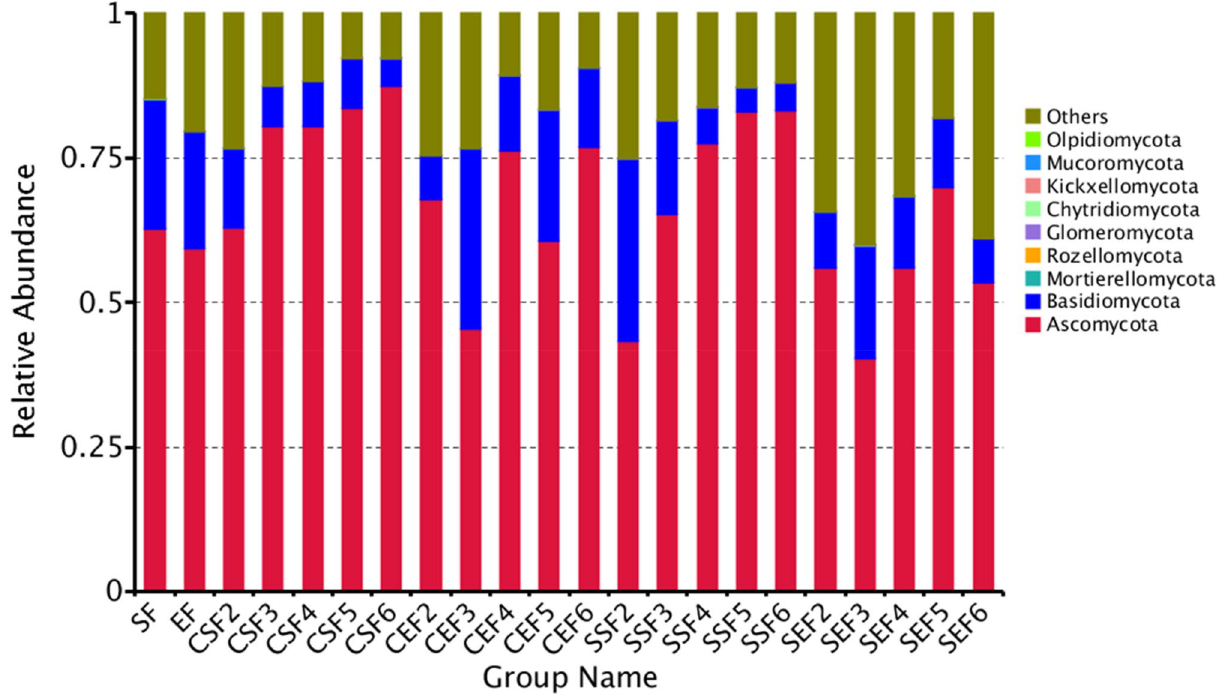
Figure 7. Histogram of relative abundances of species at the level of